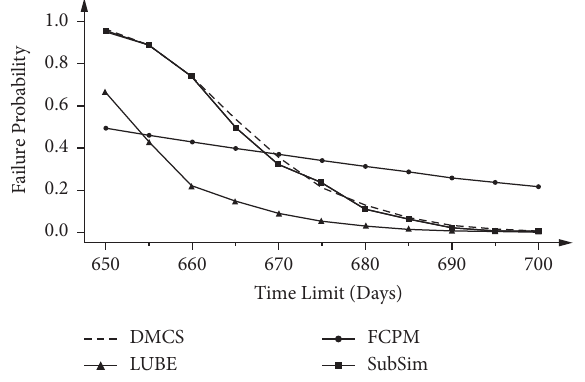
Figure 11: Failure probability